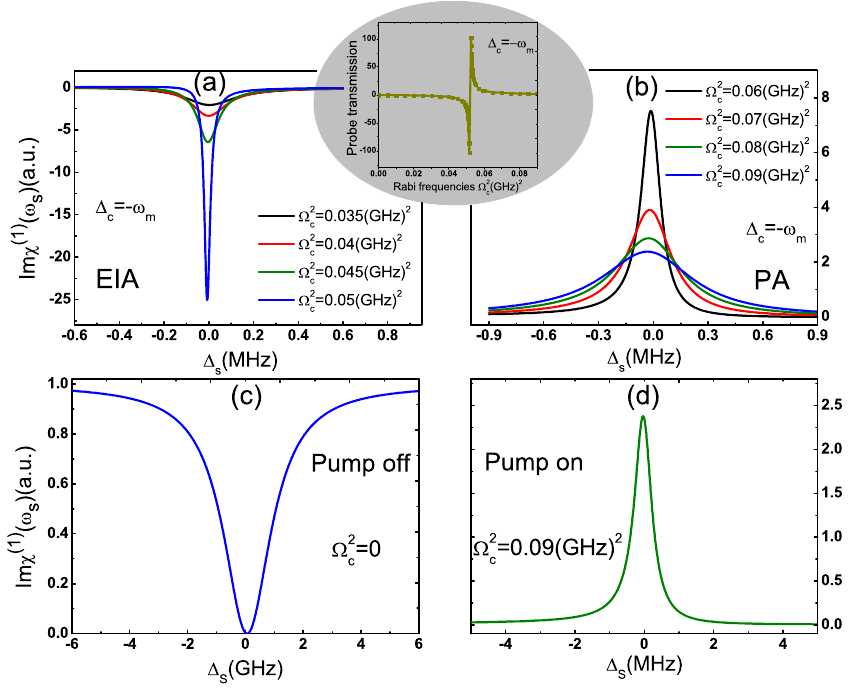
Figure 3. ( a , b ) The probe laser transmission as a function of ∆ with the increase of Rabi s = (cid:0) ! frequencies of the pump field at ∆ . The oval inset shows the relationship between c m probe transmission and pump laser intensity; ( c , d ) Attenuation and amplification of the probe laser when turning off and on the pump laser, respectively. The other parameters used are the same as Figure